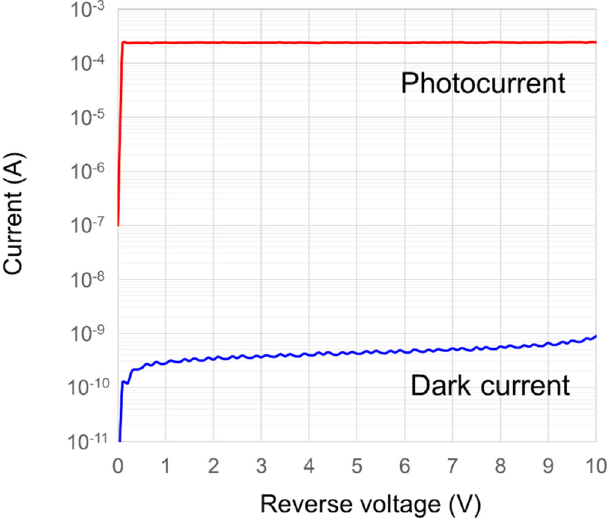
Figure 6. Current-voltage (I-V) characteristics of our inverted p-down pin photodiodes (pin-PD) with a 10- μ m active area diameter.